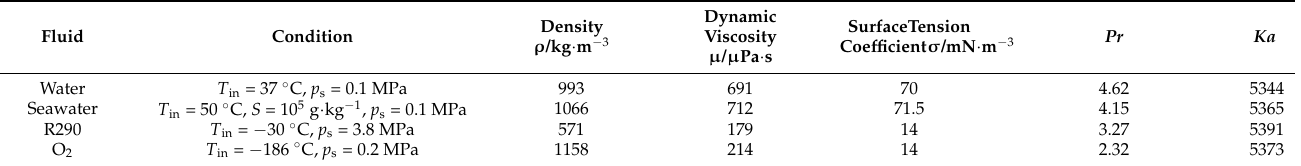
Table 1. Properties of